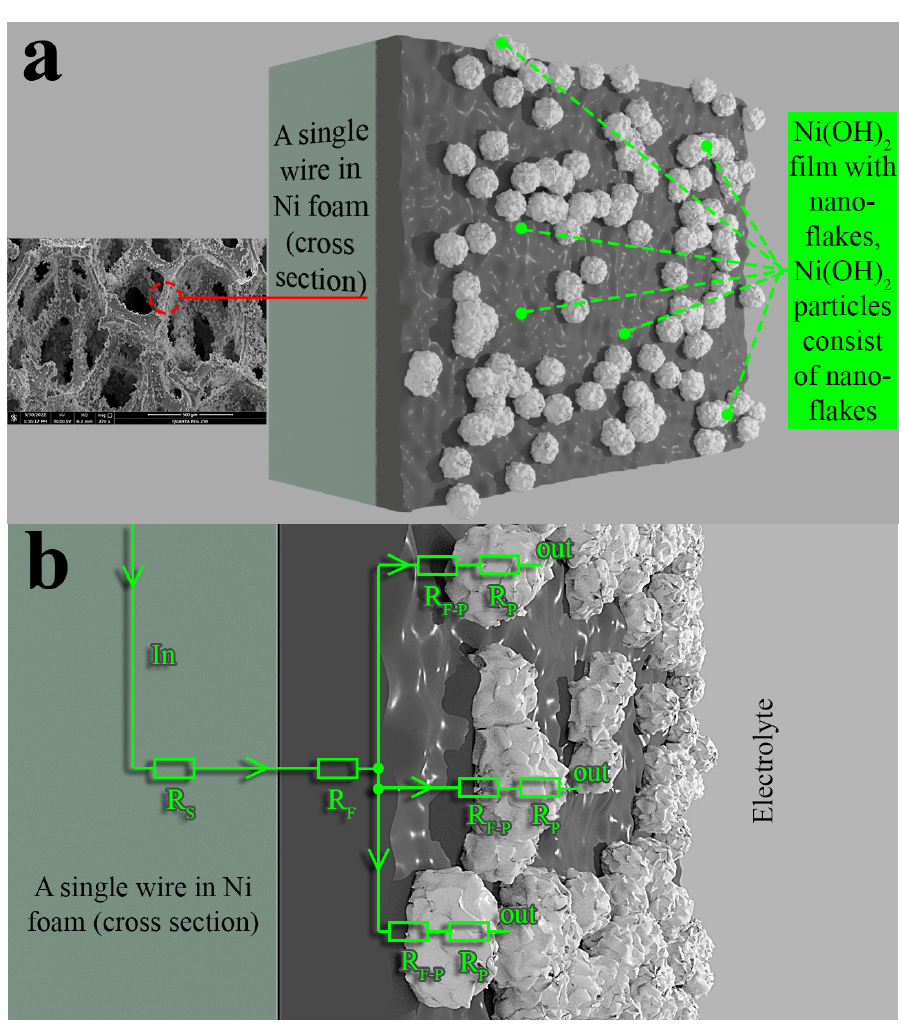
Figure 12. Generalized equivalent scheme of the electrode resistive components. 3D generated image of Ni(OH) 2 -pure electrode: ( a ) general view and ( b ) current flows through the electrode where R S— substrate resistance, R F —film resistance, R F-P —transitional resistance from film to particle, R P — resistance of a single particle.